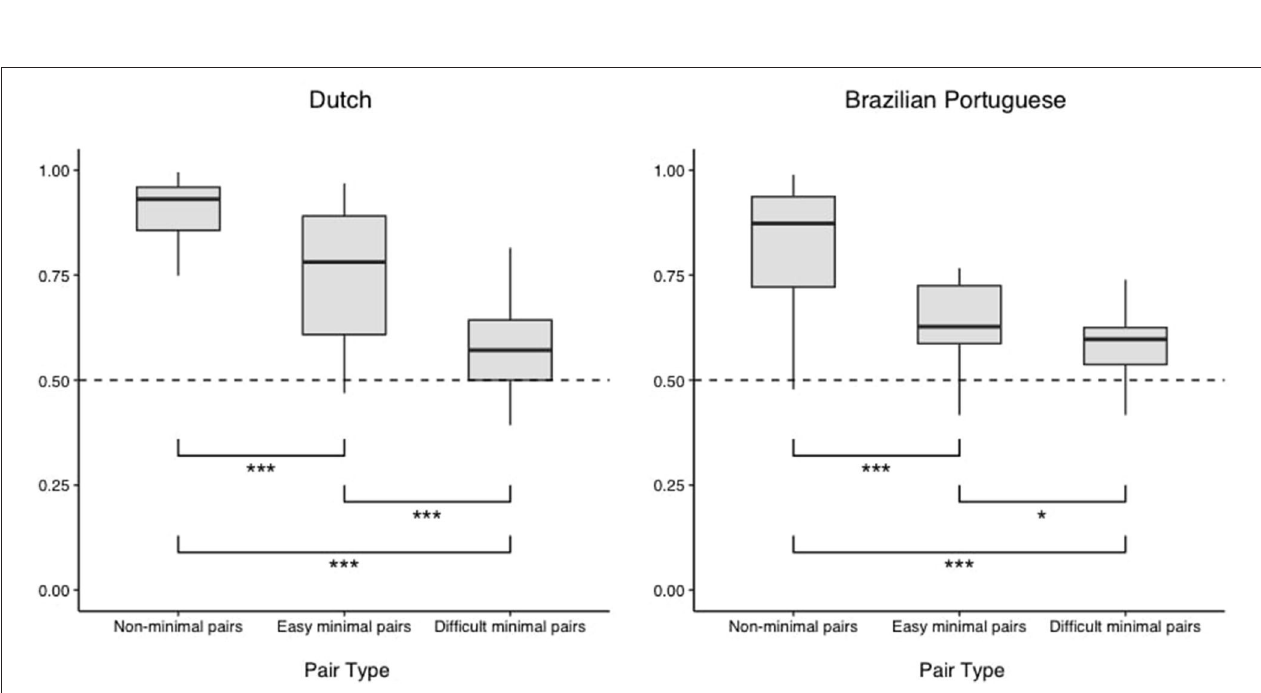
FIGURE 3 | Participants’ proportion of correct responses to different pair types when words were produced in Dutch or Brazilian Portuguese. Accuracy was above chance for all pair types. * p < 0.05; *** p < 0.001.